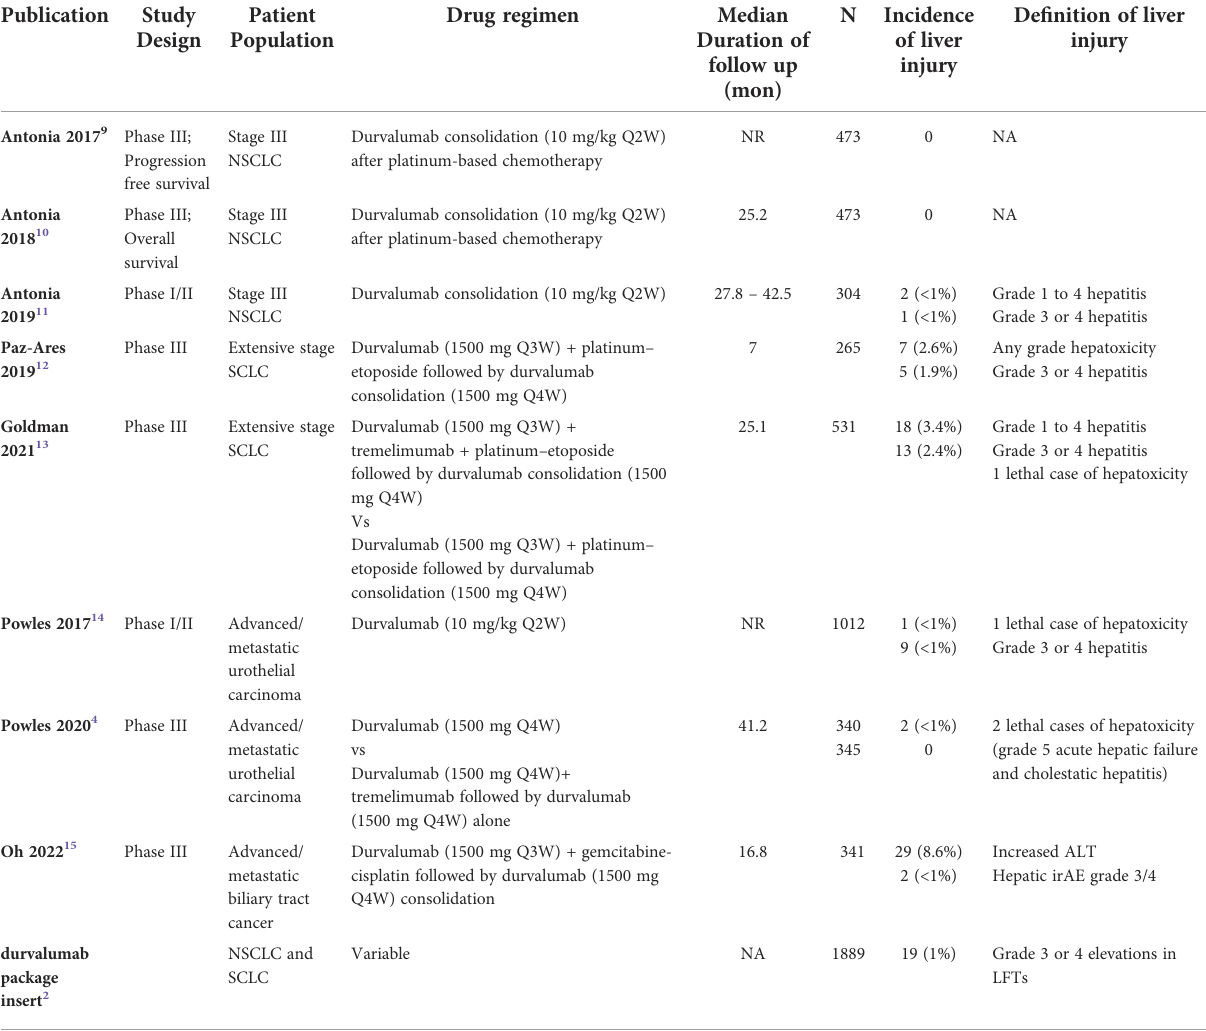
TABLE 4 Published studies of Liver Injury in patients receiving durvalumab